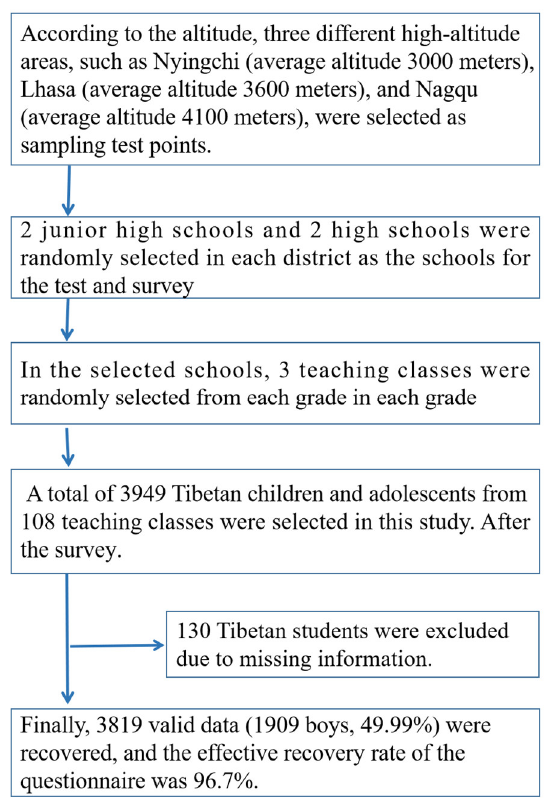
Figure 1. Sampling process of Tibetan children and adolescents in high altitude areas of China .